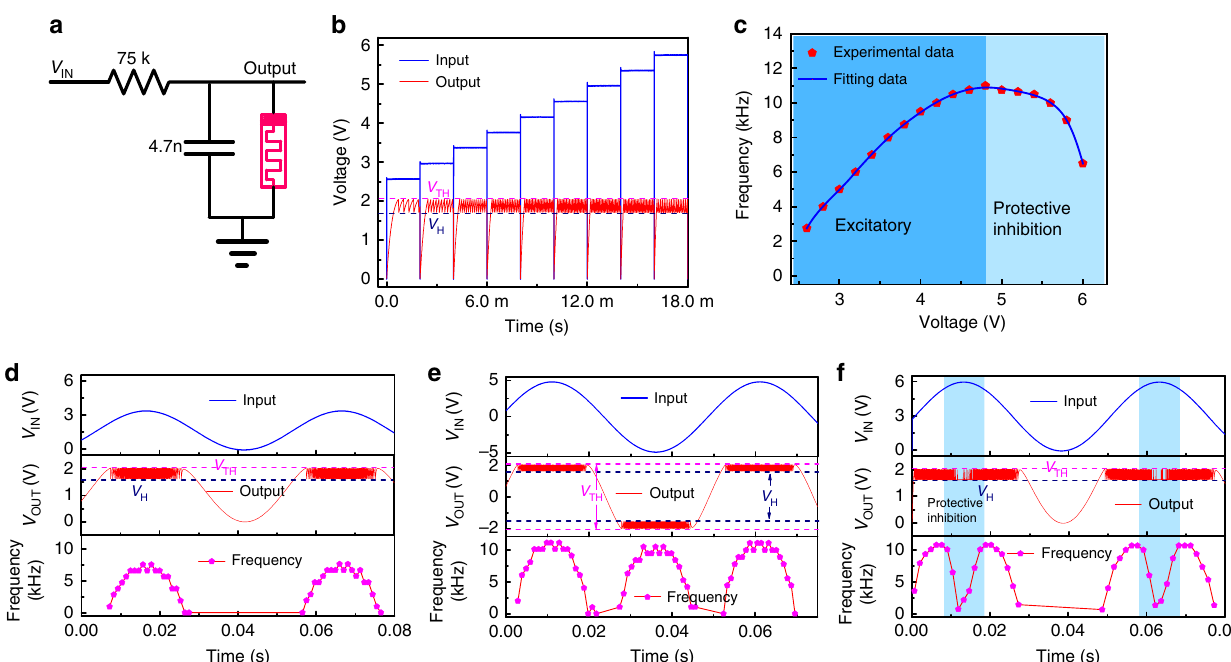
Fig. 4 Arti fi cial spiking afferent nerve (ASAN) with an external capacitor. a Schematic of the ASAN with an external parallel capacitor (4.7 nF). b Frequency response with different input voltages. c The frequency – voltage curve with two stages: excitatory spiking stage under low input voltages and protective inhibition stage under high voltages. d – f The frequency response with a sinusoidal signal as input. d , f The input signals only with positive voltage, protective inhibition can be observed in f which has a higher amplitude. e An input sinusoidal signal without bias, where the oscillation behavior can be obtained upon applications of both positive and negative